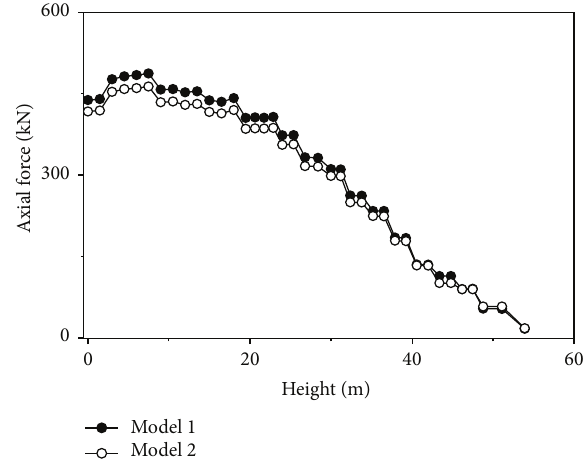
Figure 5: Comparison of the maximum axial forces of the transmis- sion towers of the two models of the suspension type.